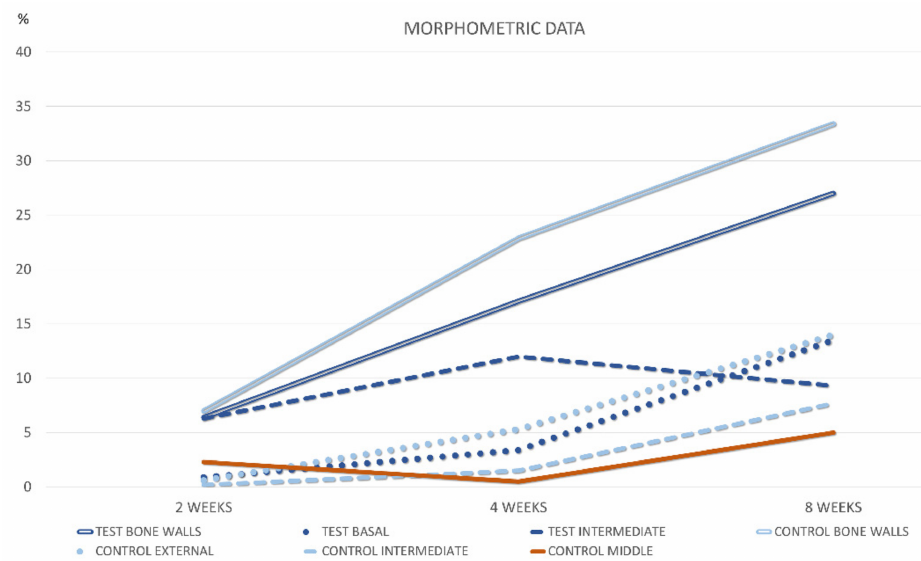
Figure 7. Graph representing new bone density in the various regions subjacent the sinus mucosa after 2, 4, and 8 weeks of healing. Table 5. Morphometric evaluation of the tissues after 4 weeks of healing in the various regions evaluated. Mean values ± standard deviation in percentages. Test sites with the inward window. Test Sites